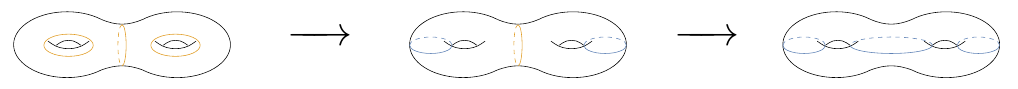
Figure 3 . Example of a crossing transformation on the g = 2 partition